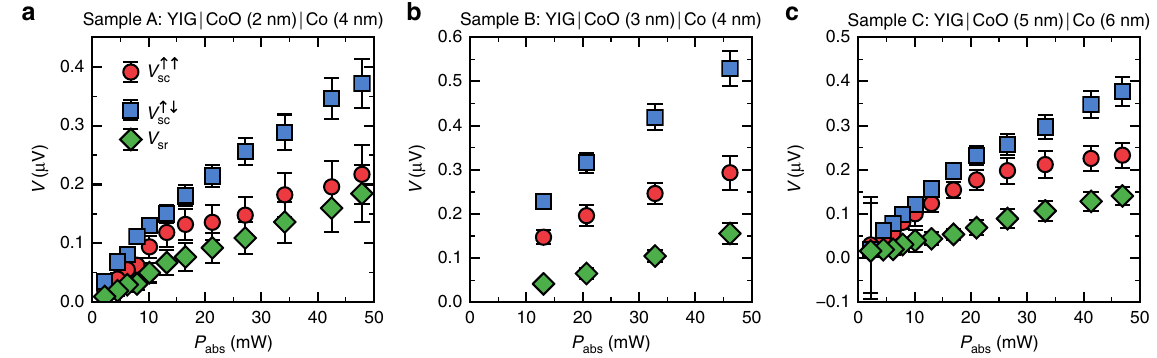
Fig. 3 Power dependence of voltage signal amplitudes. a – c Spin pumping and spin recti fi cation amplitude as a function of the absorbed microwave power for a sample A, b sample B, and c sample C. Whereas the spin recti fi cation amplitude ( V sr ) exhibits a rather linear power dependence, the spin pumping amplitude ( V sc ) follows a non-linear power dependence for both magnetization alignment states of Y 3 Fe 5 O 12 (YIG) and Co, indicating an incipient saturation. The frequency of the applied microwave is f = 4.5 GHz, the system temperature is T = 120 K. The error bars are calculated by error propagation including errors of the spin signal amplitude, as well as a systematic error estimated by the measurement device accuracy